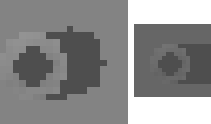
Figure 3. Examples of ray-traced tires.